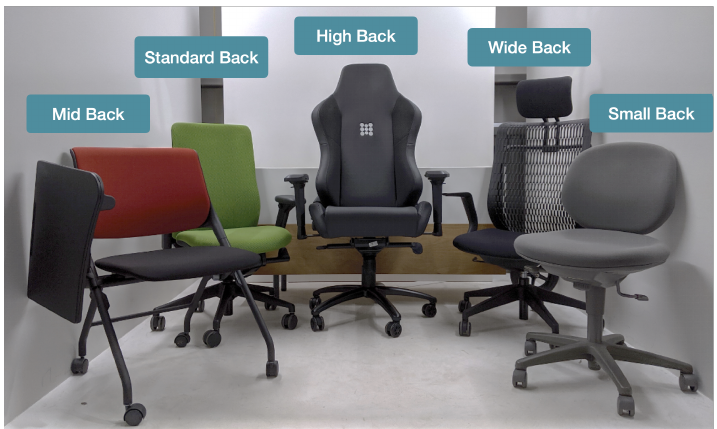
Figure 6. The five different shair types used in the portability